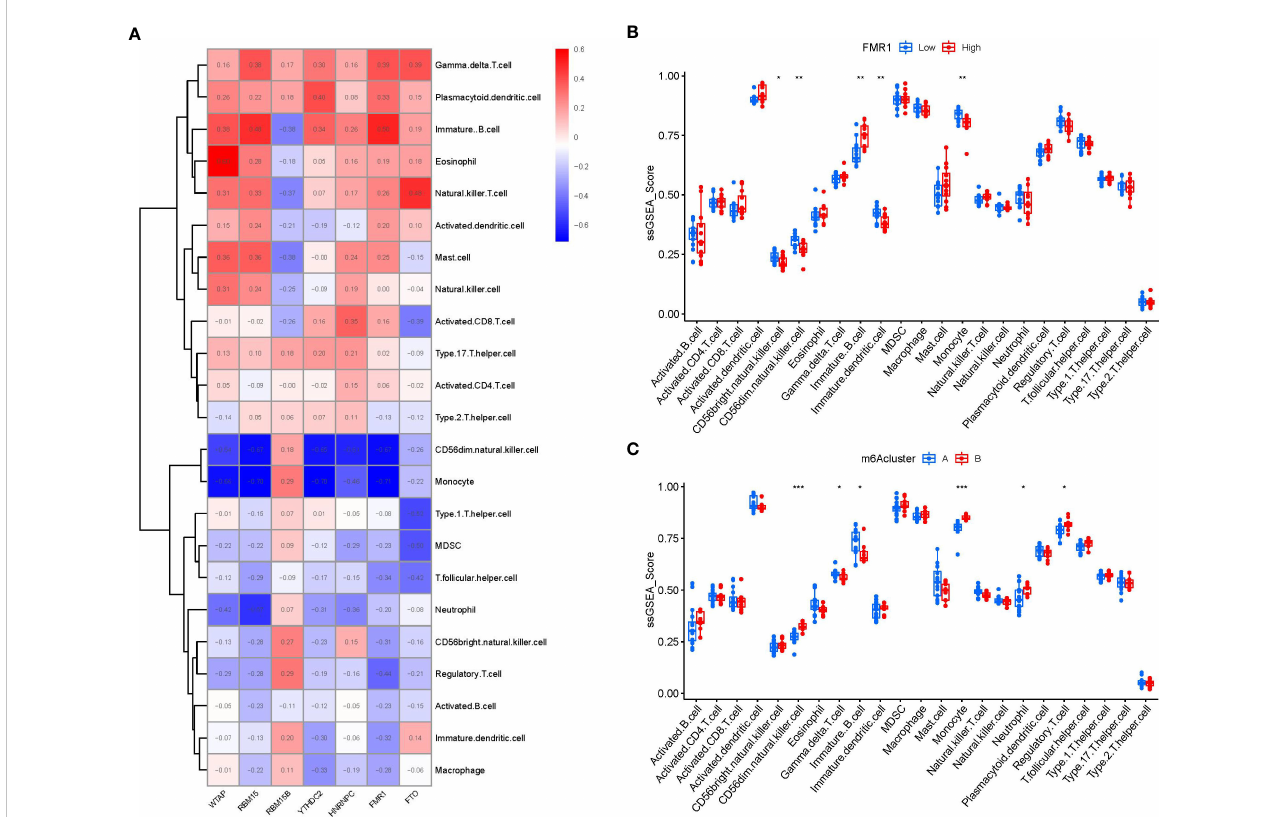
FIGURE 7 Single sample gene set enrichment analysis. (A) Correlation between immune cell in fi ltration and the 7 signi fi cant m6A modulators. (B) Difference in the abundance of in fi ltrating immune cells between high and low FMR1 protein expression groups. (C) Differential immune cell in fi ltration between clusterA and clusterB. *p < 0.05, **p < 0.01, and ***p <